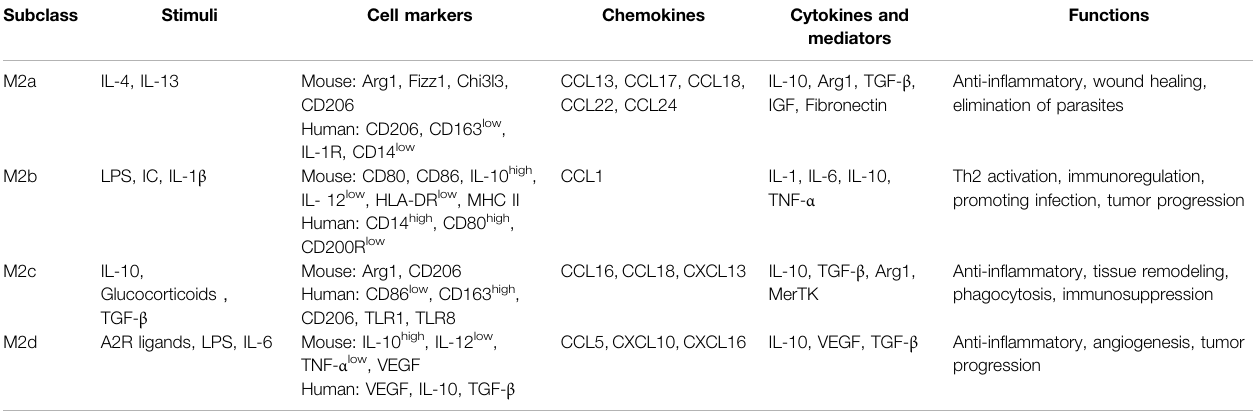
TABLE 1 | Different subclasses of M2